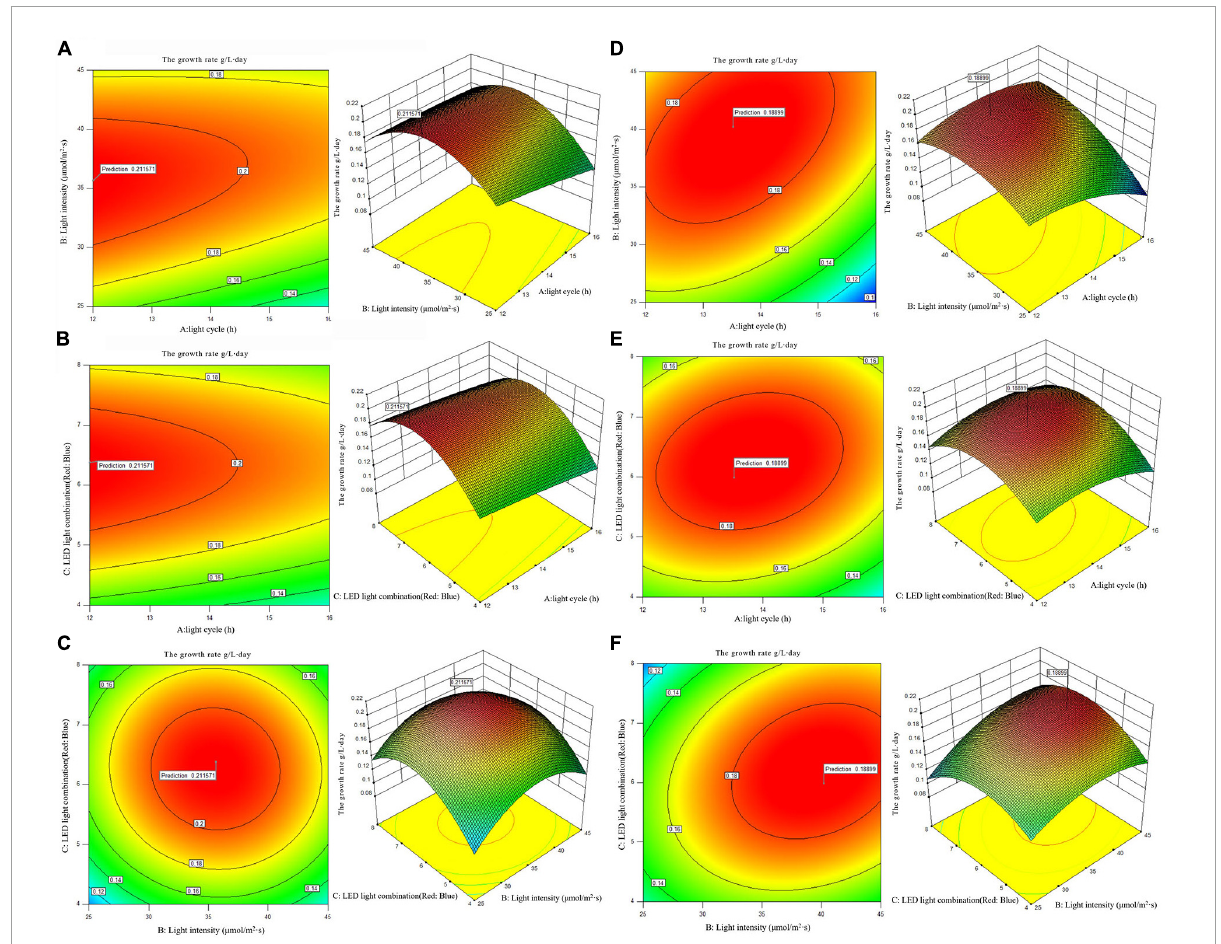
FIGURE2 2D contour diagram and 3D surface diagram of growth rate of Arthrospira platensis OUC623 and A. platensis OUC793. (A) Contour diagram and response surface diagram of growth rate of 623 with light time (12, 14, and 16 h) and light intensity (25, 35, and 45 µ mol/m 2 s) under the light of red6: blue 1. (B) Contour diagram and response surface diagram of growth rate of 623 with light time (12, 14, and 16 h) and red and blue light combination (red: blue = 4:1, 6:1, 8:1) under light intensity of 35 µ mol/m 2 s. (C) Contour diagram and response surface diagram of growth rate of 623 with red and blue light combination (red: blue = 4:1, 6:1, 8:1) and light intensity (25, 35, and 45 µ mol/m 2 s) under the light cycle of L14:D10. (D) Contour diagram and response surface diagram of growth rate of 793 with light time (12, 14, and 16 h) and light intensity (25, 35, and 45 µ mol/m 2 s) under the light of red6: blue 1. (E) Contour diagram and response surface diagram of growth rate of 793 with light time (12, 14, and 16 h) and red and blue light combination (red: blue = 4:1, 6:1, 8:1) under light intensity of 35 µ mol/m 2 s. (F) Contour diagram and response surface diagram of growth rate of 793 with red and blue light combination (red: blue = 4:1, 6:1, 8:1) and light intensity (25, 35, and 45 µ mol/m 2 s) under the light cycle of